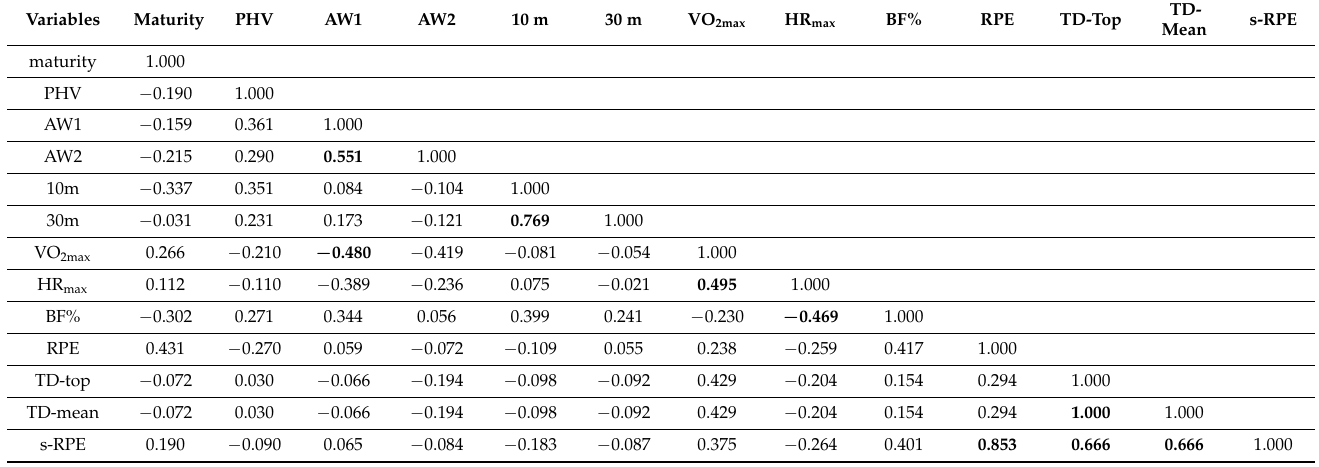
Table 3. Matrix of correlations of variables’ accumulated workload (AW) based on periods (i.e., first and second halves) with maturity (i.e., maturity offset and peak height velocity; PHV), linear sprints (i.e., 10 m and 30 m), maximum oxygen uptake (VO 2max ), maximum heart rate (HR max ), body fat, RPE, s-RPE, TD-top, and